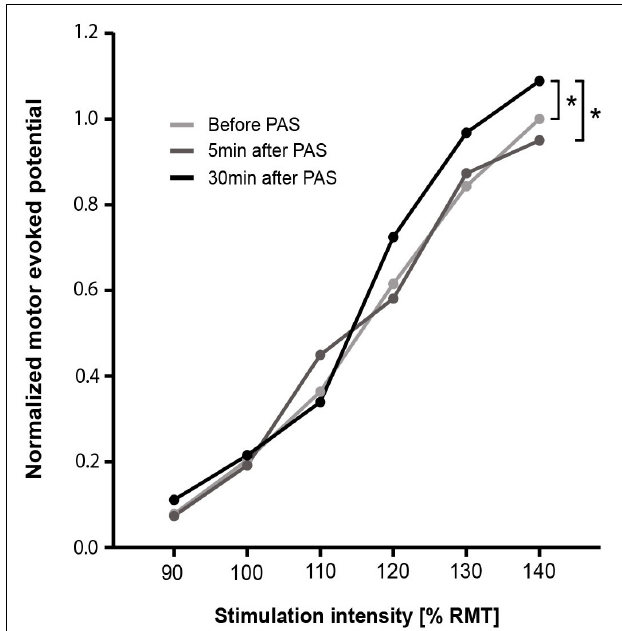
FIGURE 2 | Recruitment curve of normalized MEP peak-to-peak amplitudes for before, 5 min after, and 30 min after PAS. Data points are median values. For each stimulation intensity, the comparison of before, 5 min after, and 30 min after PAS was performed using Friedman test. Dunn–Bonferroni post hoc test was performed when a significant comparison was analyzed. ∗ p < 0.05. PAS, paired associative stimulation; RMT, resting motor threshold.